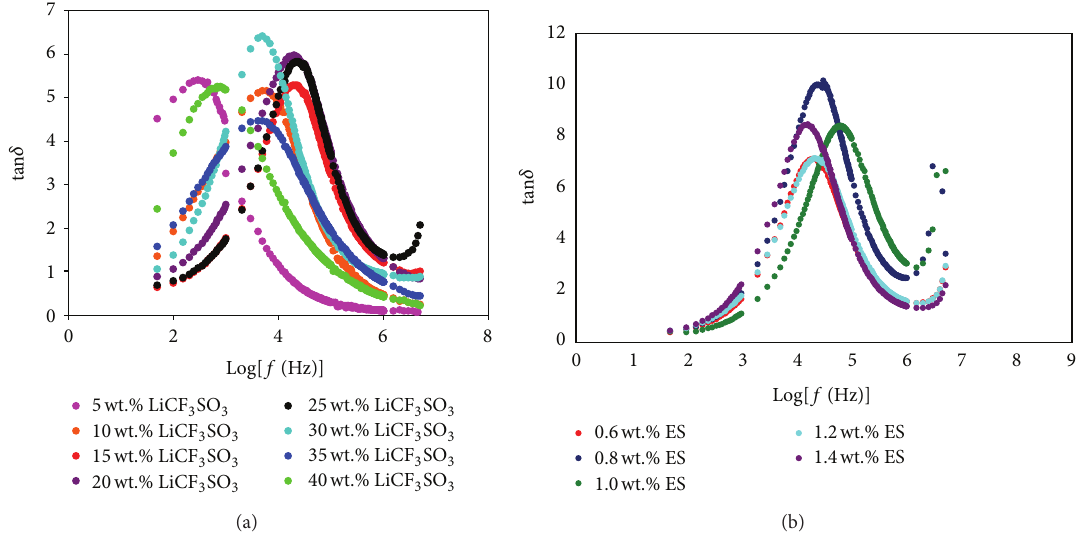
Figure 9: The frequency dependence of tan 𝛿 at room temperature: (a) salted system and (b) plasticized system for selected sample.